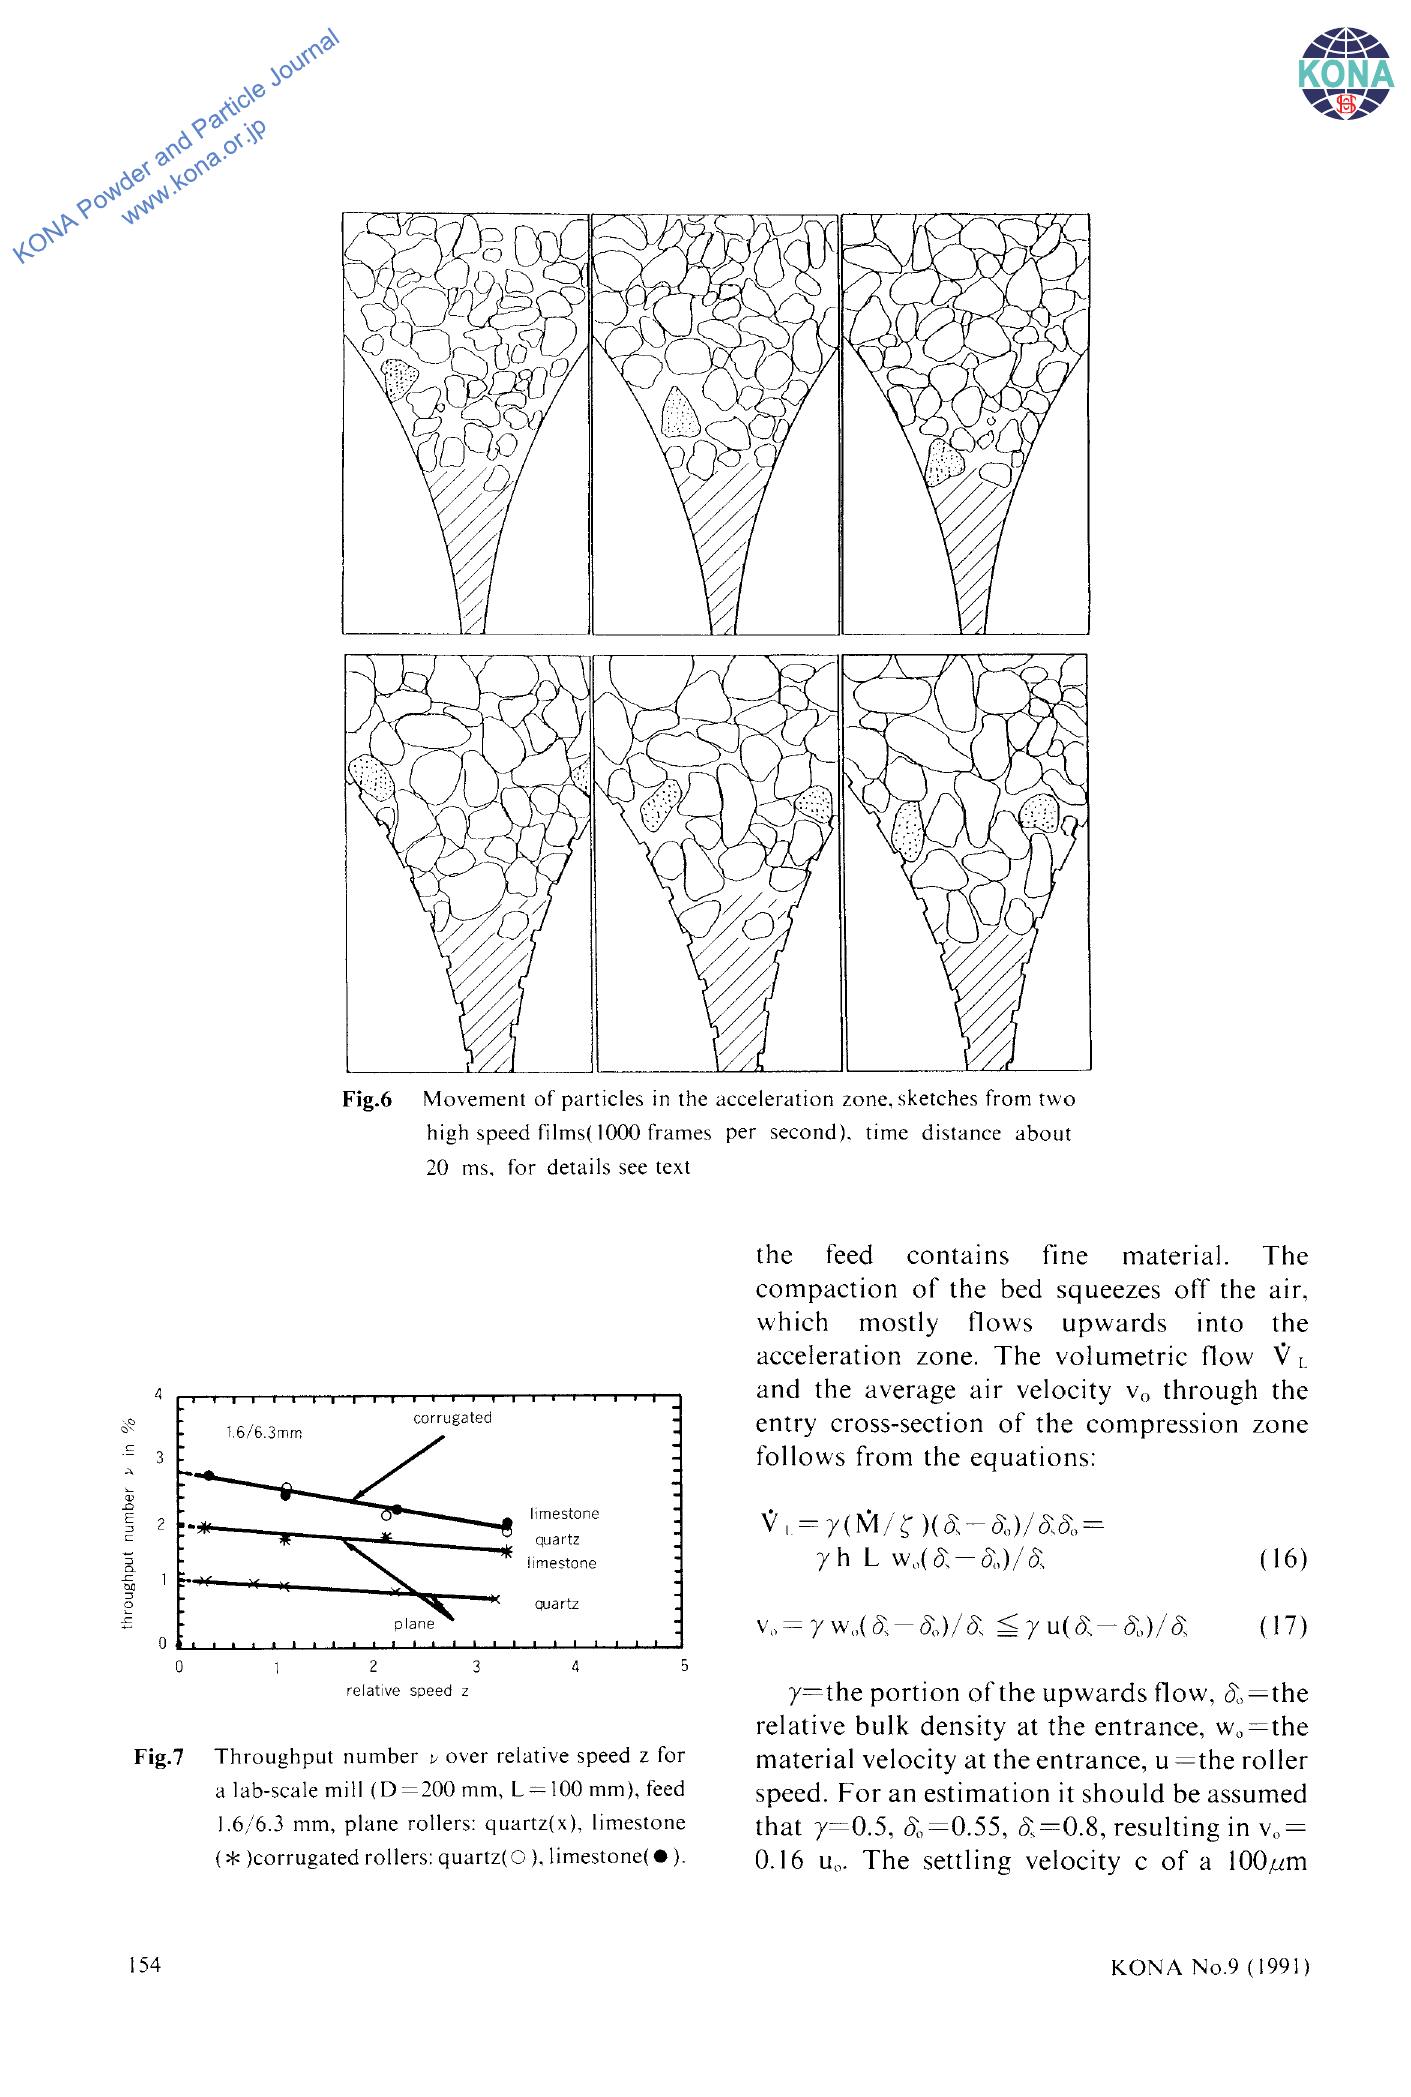
Fig.7 Throughput number v over relative speed z for a lab-scale mill (0=200 mm, L= 100 mm), feed 1.6/6.3 mm, plane rollers: quartz(x), limestone (*)corrugated rollers: quartz( 0 ). limestone( •